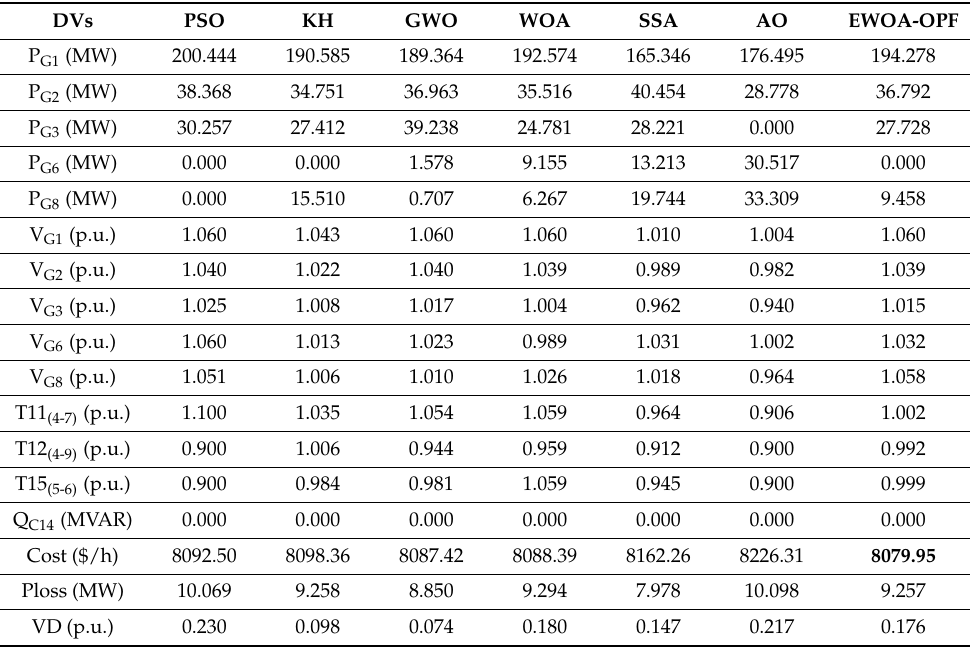
Table 4. Results of OPF for IEEE 14-bus test system on Case 1.